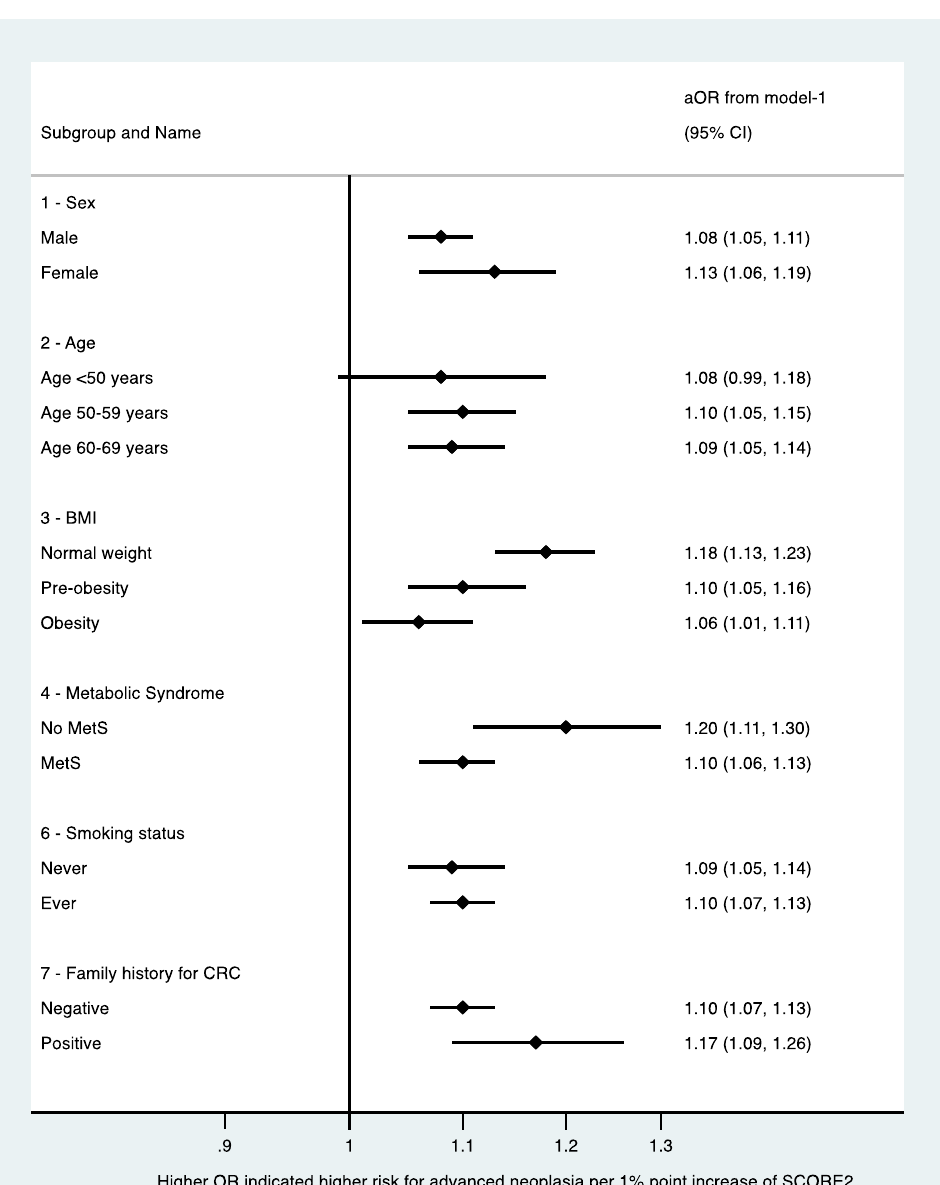
Figure 4. Sensitivity analyses stratifying the presence of the primary endpoint (any colorectal neoplasia) according to patient-specific baseline characteristics (stratified for sex, age (in categories), BMI (in categories according to the World Health Organization), smoking status, metabolic syndrome, and positive family history). For the sensitivity analyses, model-1 was fitted with SCORE2 as continuous variable as independent variable and advanced colorectal neoplasia as dependent variable in the strata. We plotted the OR and 95%CI. Abbreviations: BMI: body mass index; CI: confidence interval; and OR: odds ratio.